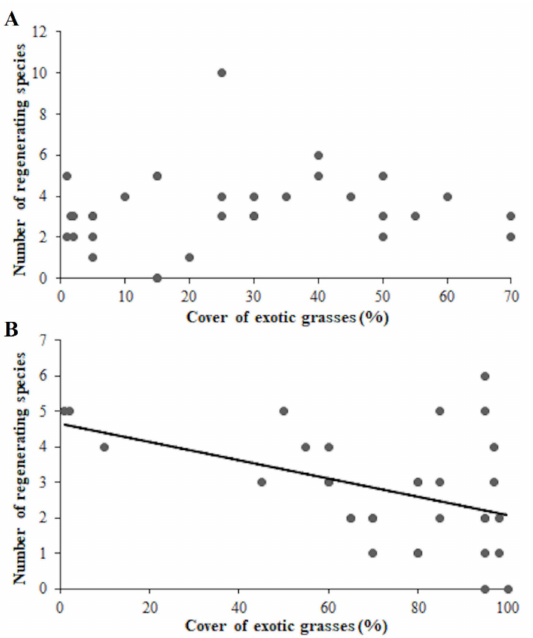
Figure 2. Number of regenerating morphospecies related to the cover of exotic grasses in ( A ) November 2017 and ( B ) April